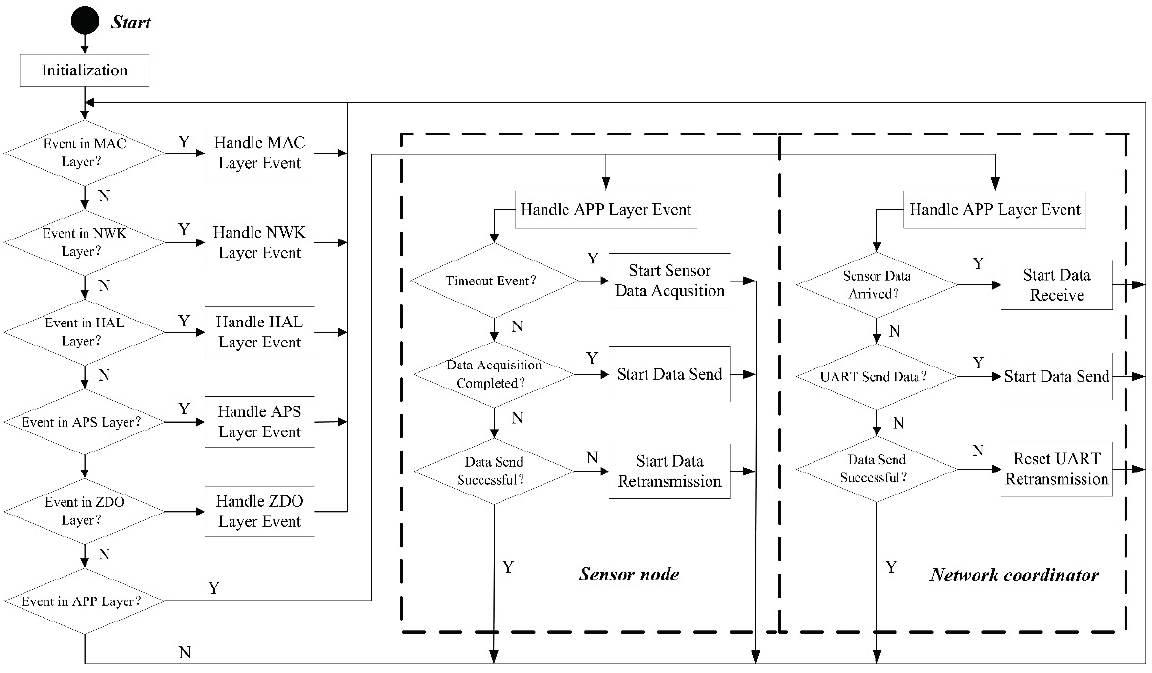
Figure 4. Flow chart of the sensor data acquisition at the sensor node and the data transceiver process at the network coordinator.